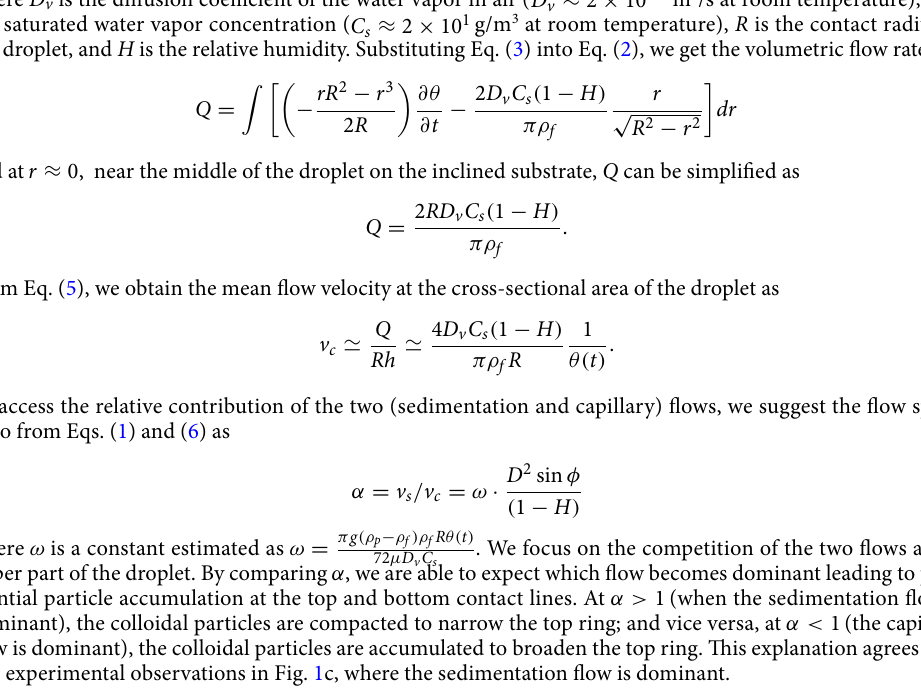
Figure 1. Evaporation and deposition of colloidal droplets on inclined substrates. ( a ) The side-view image of a 3 µ l colloidal droplet at the inclination angle 30 ◦ taken with the drop shape analyzer. ( b ) A schematic illustration of a colloidal droplet at the inclination angle φ under gravity F g . The droplet height h ( r , t ) depends on the position r and time t . The asymmetric droplet geometry affects the local evaporation flux J : typically, the evaporation flux is greater at the small contact angle ( θ r ) than at the large contact angle ( θ a ). For each position, the arrows mark the difference in evaporation flux. The two flows, v s and v c , represent the sedimentation flow and the capillary flow, respectively. ( c ) The final deposit from ( a ) after evaporation. The two (sedimentation and capillary) flows would contribute to the ring widths at the top ( d top ), the bottom ( d bottom ), and the side ( d side ) positions. The two flows compete in the upper part and cooperate in the lower part in the evaporating droplet, as illustrated by the blue and red